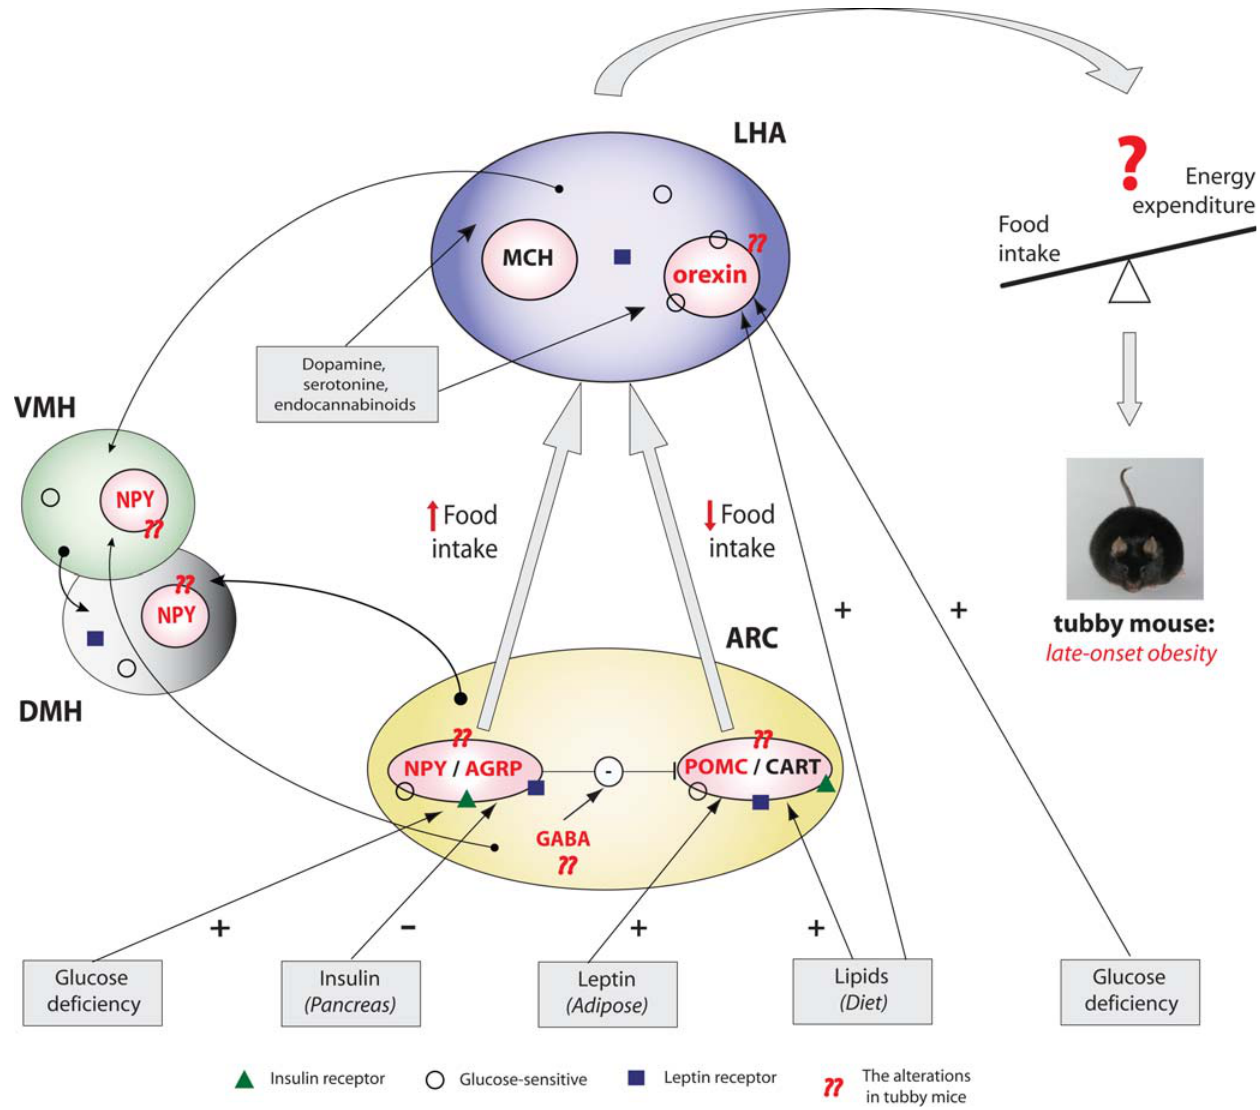
Figure 2. The interactions between the neuropeptides in the hypothalamus regulating energy homeostasis and its alteration in tubby mice. Signals related to diet and circulating nutrients (shown at the bottom), which stimulate ( + ) or inhibit ( 2 ) the production of peptides, are received by the various hormonal receptors in the ARC nuclei, which contain NPY/AGRP- and POMC/CART-producing groups of cells. The activation of NPY/AGRP neurons promotes food intake, whereas POMC/CART neurons have the opposite effect. Both signals project onto LHA neurons that express MCH and orexin (important stimulators of food intake), which are also mediated by dopamine, serotonin and endocannabinoids. The loss of the TUB function in tubby mice causes alteration in the expression of different neuropeptides, such as AGRP, NPY and POMC in ARC, as well as upregulation of NPY by , 30-fold in DMH/VMH and orexin by , 60-fold in LHA (highlighted in red). The image of tubby mice was provided by J.Naggert and P. Nishina (Nat. Genet. 39,149; 2007). Abbreviations: AGRP, agouti-related protein; ARC, arcuate nucleus; CART, cocaine–amphetamine-regulated transcript; DMH